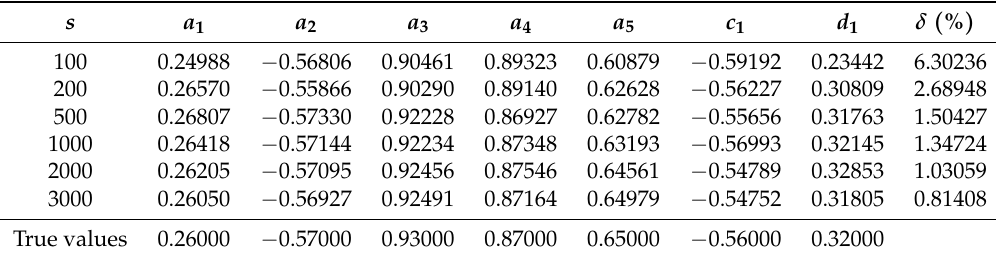
Table 4. The PC-RGELS estimates and their errors with σ 2 = 0.20 2